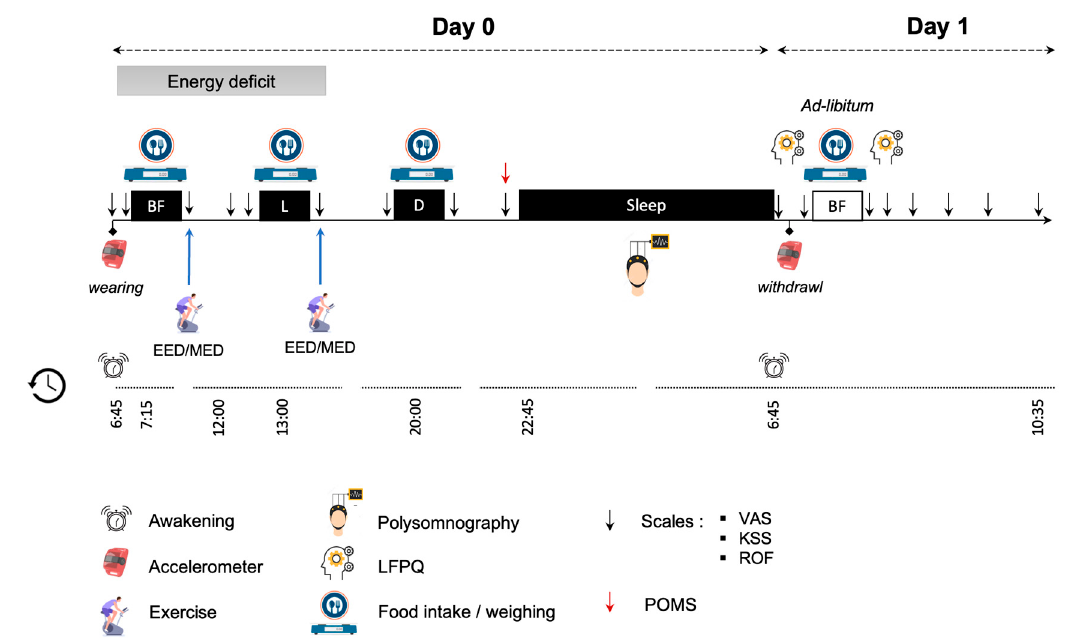
Figure 2. Experimental session design: BF, breakfast; D, dinner; EED, exercise-induced energy deficit session; KSS, Karolinska Sleepiness Scale; L, lunch; LFPQ, Leeds Food Preference Questionnaire; MED, mixed energy deficit session; POMS, Profile of Mood States questionnaire; ROF, Rating-of-Fatigue Scale; VAS, visual analogue scale.